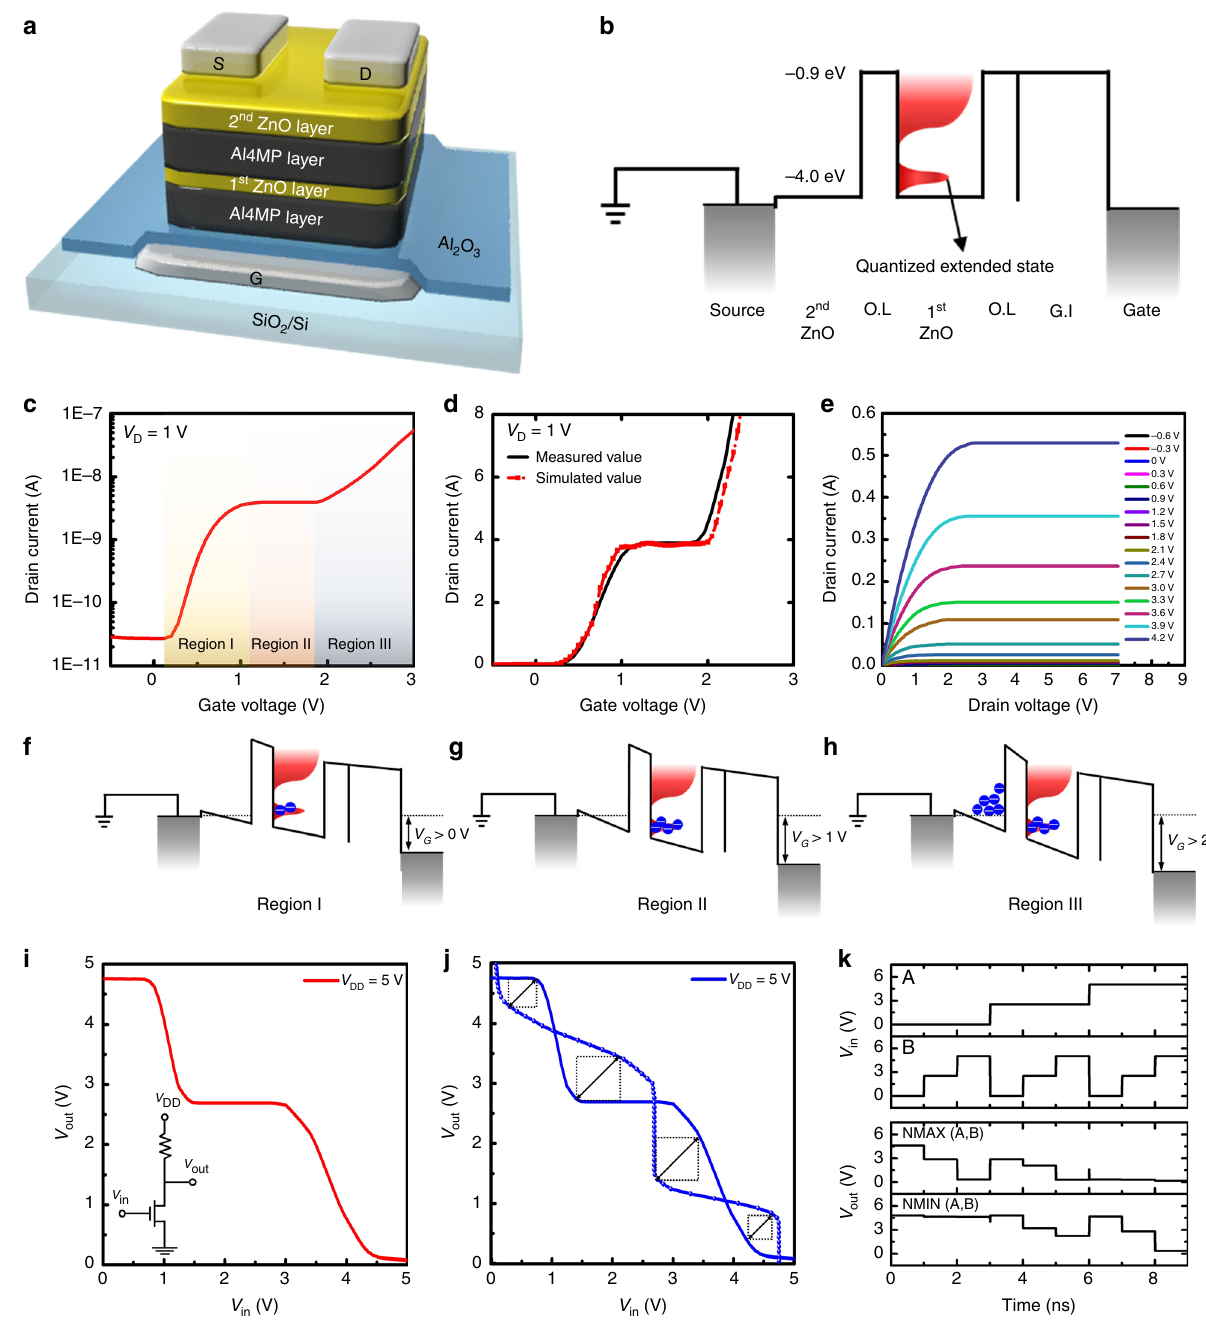
Fig. 3 A ternary transistor with double zinc oxide (ZnO) composite nanolayers. a Schematic of the structure of the ternary transistor. b Energy band diagram of the ternary transistor at the grounded state ( V G = 0). c Transfer characteristics of the ternary transistor at V D = 1 V. d Measured and simulated transfer characteristics of the ternary transistor at V D = 1 V. e Output ( I D – V D ) characteristics of the ternary transistor at various V G values. f – h Idealized representation of energy band diagrams from the source to the gate in the ternary transistor. Band diagrams matched to Region I ( f ), Region II ( g ), and Region III ( h ), as denoted in Fig. 3c, respectively. i Voltage transfer characteristics of the ternary inverter fabricated using the ternary transistor. The inset shows a circuit schematic of the ternary inverter. j Butter fl y voltage transfer characteristics for static noise margin. k Transient responses of ternary transistor based NMIN and NMAX